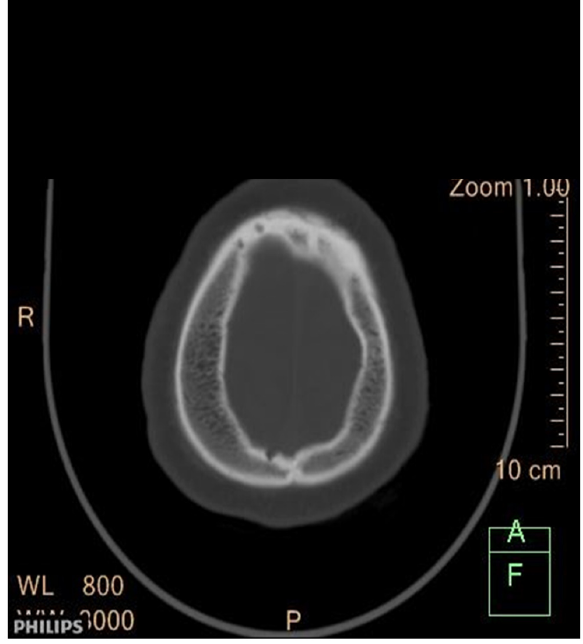
Figure 3. CT scan of the head (axial view). Shows a marked thickness on the right side of the